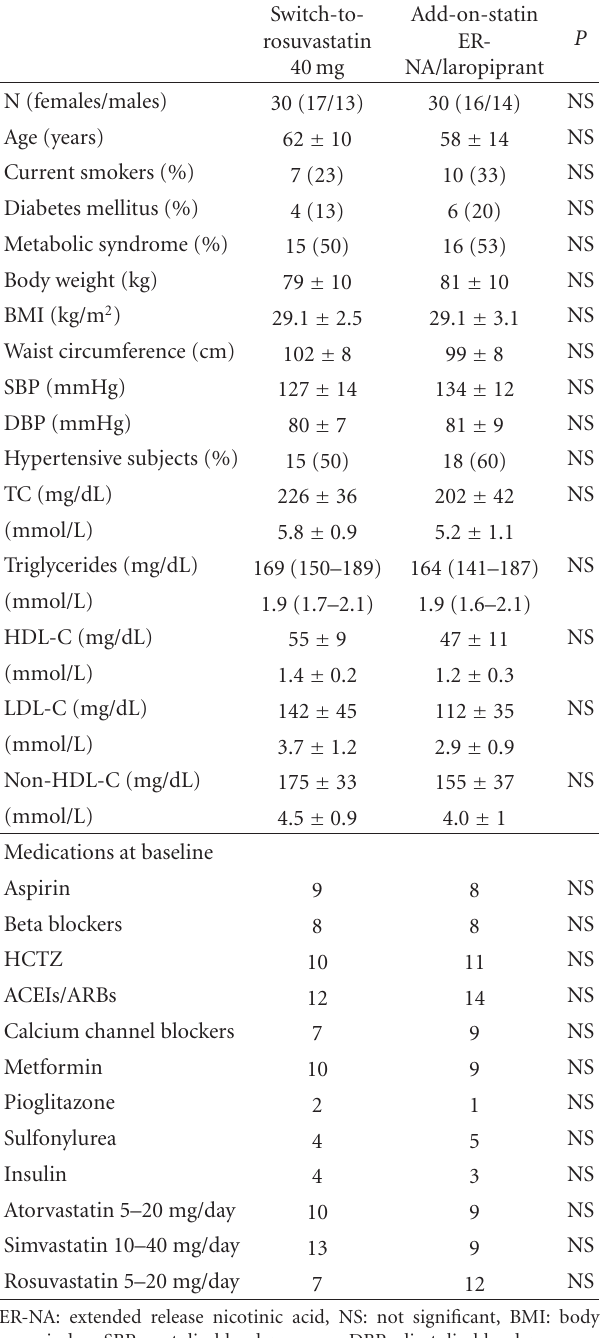
Table 1: Baseline characteristics and medications of study partici- pants ∗ ( n =